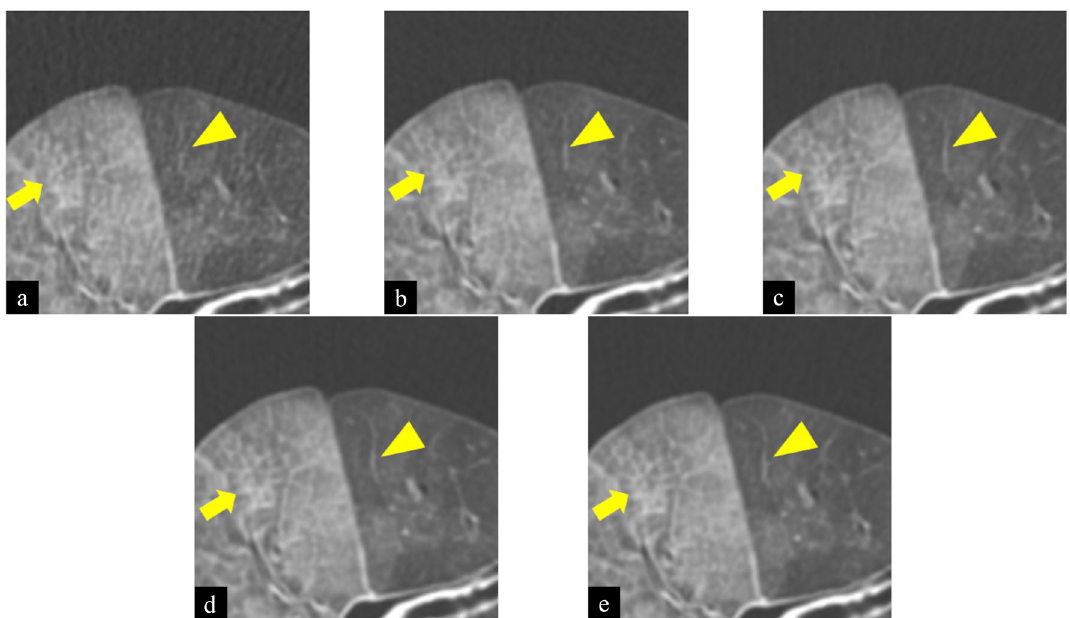
Figure 2. Images of True Fidelity Image (TFI) of cadaveric lung (diffuse alveolar hemorrhage) at 10 ( a ), 25 ( b ), 50 ( c ), 75 ( d ), and 100 mAs ( e ). Window width was 1200 and Window level was − 700 (Hounsfield Unit). Scan field of view was 20 cm. The length and width of each figure was 6.5 cm. As tube current–time product decreased, the shape of the small vessel (arrowhead) and reticulation (arrow) became obscured. In addition, noise and streak artifacts